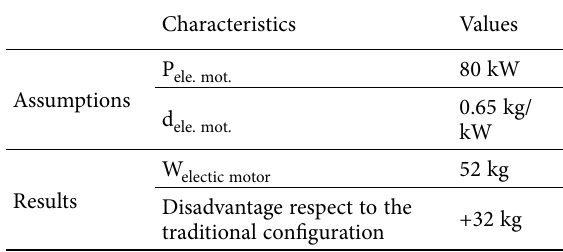
Table 3. Summary of electric motor sizing